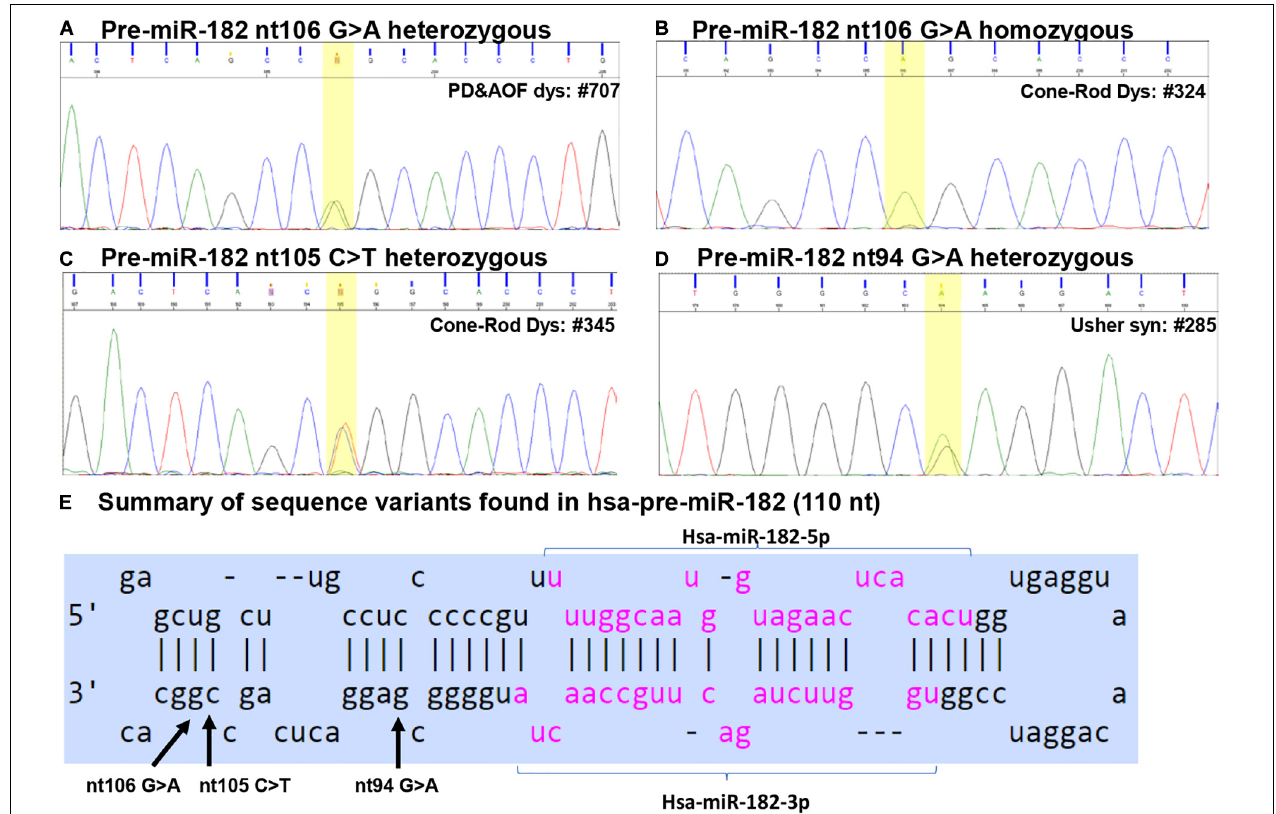
FIGURE 2 | Sequence variants identified in pre-miR-182. (A–D) Example of Sanger sequencing chromatography of patient DNA samples which are heterozygous for pre-miR-182 nt106 G/A alleles (A) and homozygous for pre-miR-182 nt106 A/A allele (B) , heterozygous for pre-miR-182 nt105 C > T (C) and nt94 G > A variants (D) . (E) Summary of the sequence variants of pre-miR-182 in the context of the hairpin structures of hsa-miR-182. Reference: miRbase.org.